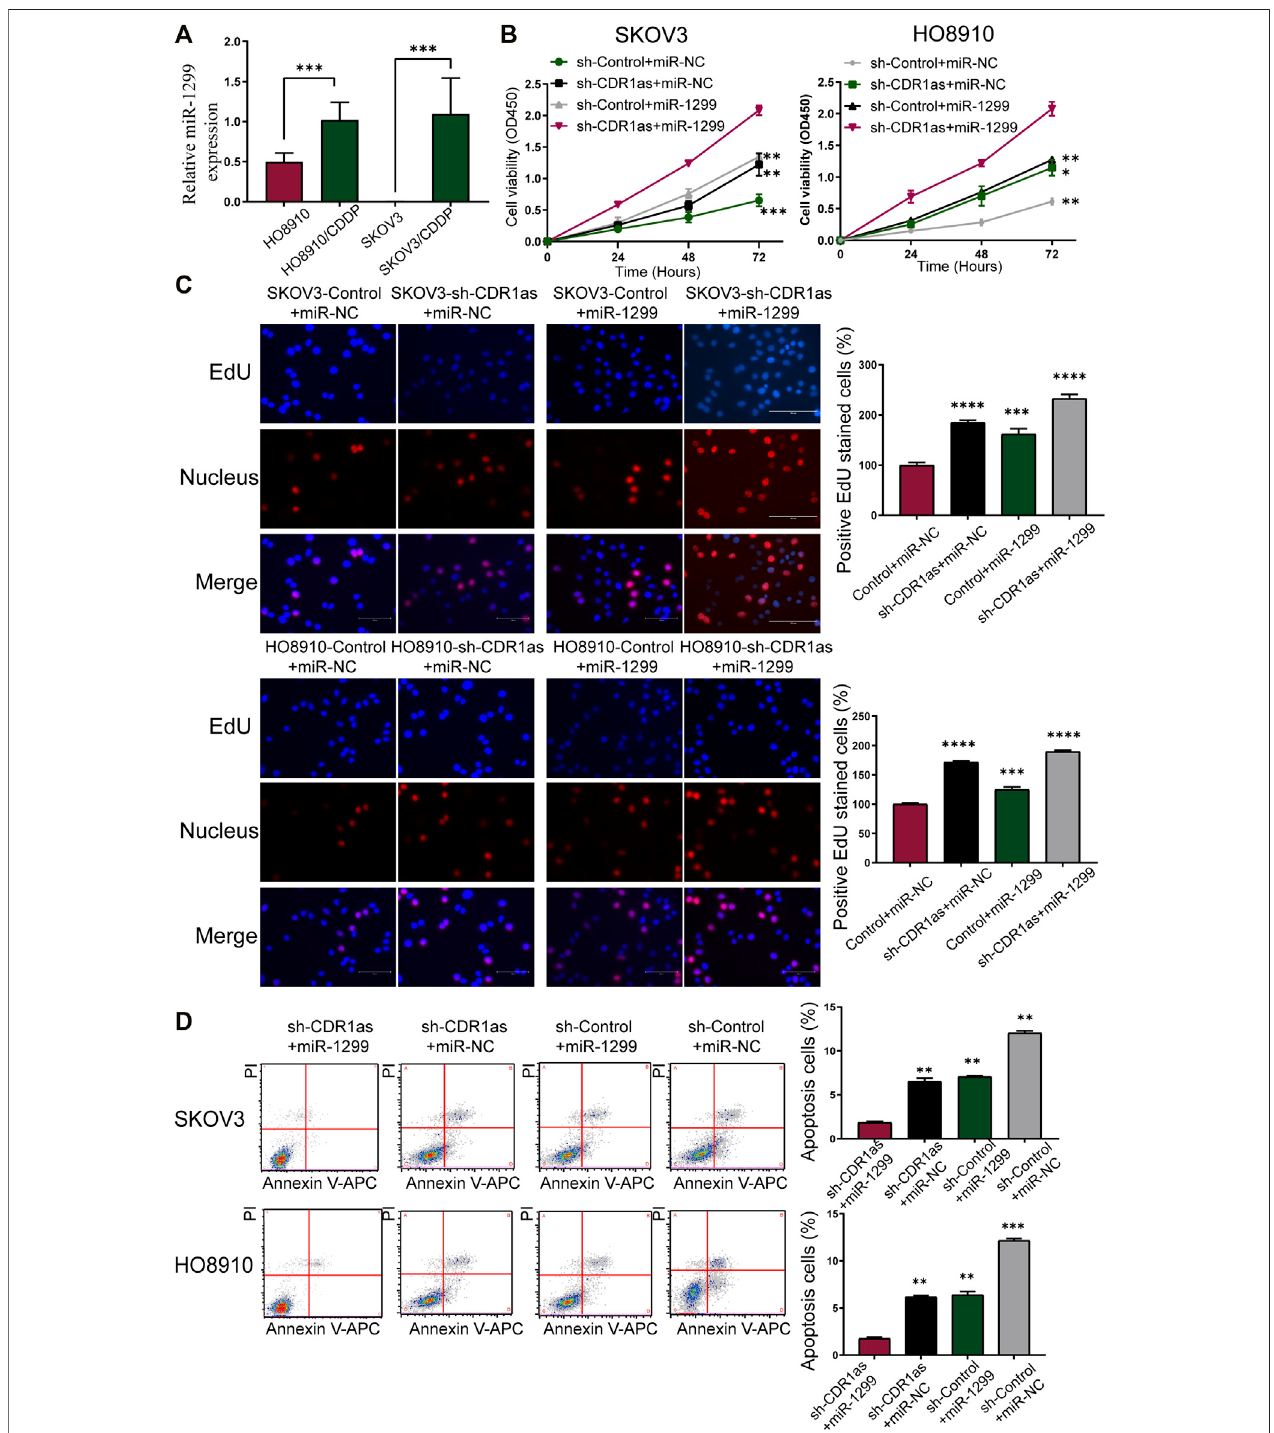
FIGURE7| TherelationshipbetweenmiR-1299 andCDR1asinOCcells. (A) Theexpression ofmiR-1299incelllinesbyqRT-PCR. (B,C) ProliferationofCDR1as- knockout OC cells that transfected with miR-1299 mimic or miR-NC was detected by CCK-8 (B) and EdU assays (C) . (D) Flow cytometry analyzed the CDR1as- knockout OCcell apoptosis ratewith or without miR-1299 transfected. Theseresults were presented asthe mean± SDs. * p < 0.05, ** p < 0.01, *** p < 0.001, and **** p < 0.0001.